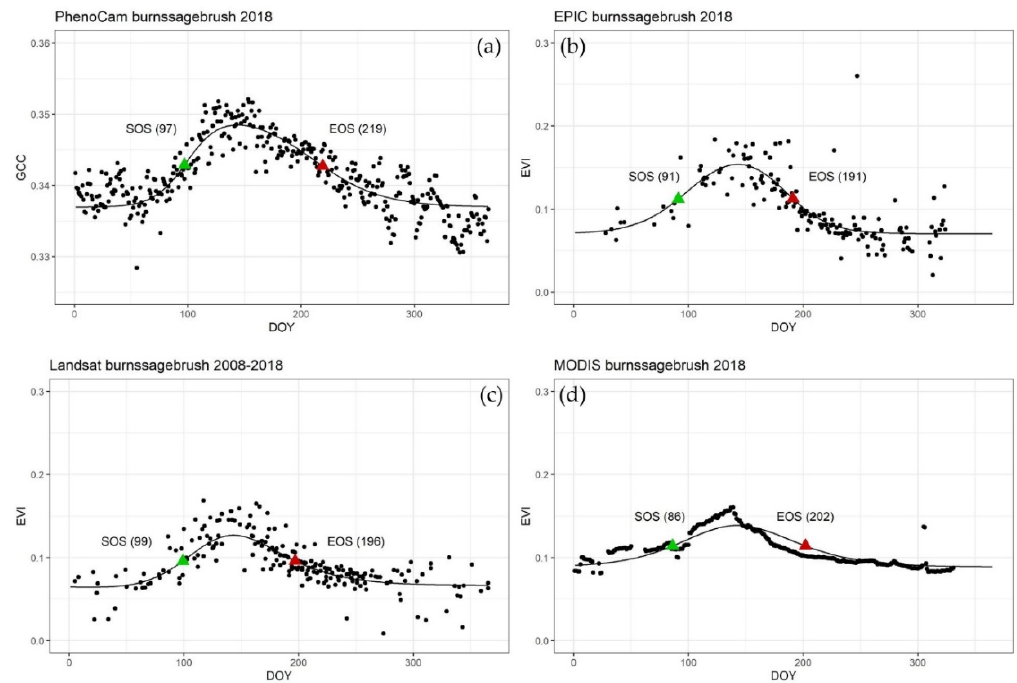
Figure A2. Derived vegetation phenology indicators of SOS and EOS from EVI for shrub study site ‘burnssagebrush’ based on ( a ) PhenoCam, ( b ) EPIC, ( c ) Landsat, and ( d ) MODIS observations. The green triangles indicate SOS, and the red triangles indicate EOS for each time series. The y-axis scale was kept constant for Landsat, MODIS, and EPIC, but adjusted for PhenoCam to better show the shape of the curve. Remote Sens. 2020 , 12 , x FOR PEER REVIEW